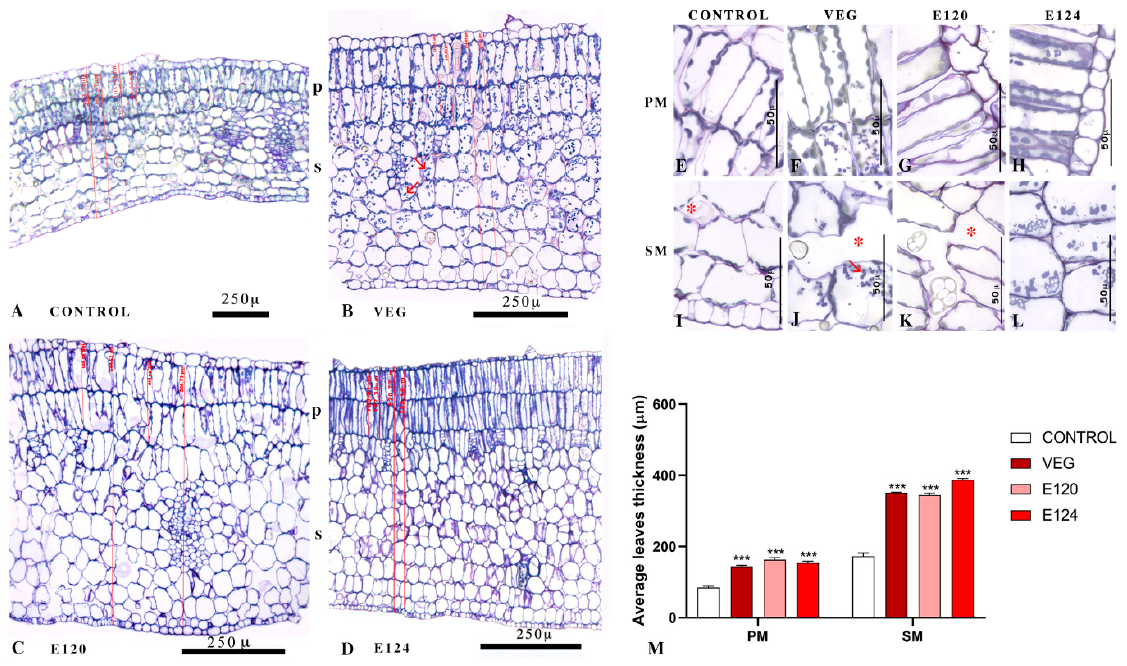
Figure 7. Effect of vegan red VEG, E120, or E124 on cotyledonary leaves. ( A ): normal morphology of palisade (p) and spongy (s) mesophyll. ( B – D ): hyperplasia and hypertrophy of mesophyll. Arrows indicate amyloplasts. Vertical red lines indicate some of the measures used to determine average thickness. Detail of palisade ( E – H ) and spongy ( I – L ) cells. Notice the presence of large intercellular spaces (asterisks) and the increase in amyloplasts after VEG treatments (arrows). ( M ): Average thickness of spongy (SM) and palisade (PM) mesophyll. (Data are mean ± SE; n = 20; *** p < 0.001).